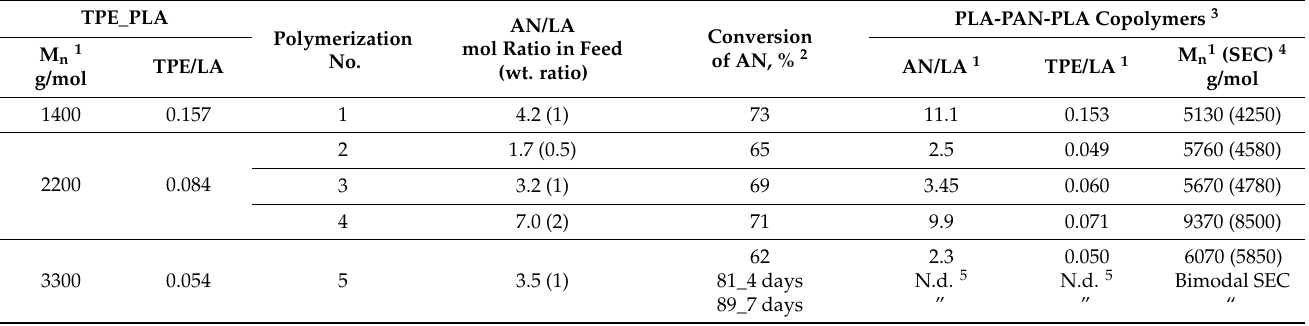
Table 1. Polymerization of acrylonitrile at 85 °C for 24 h.